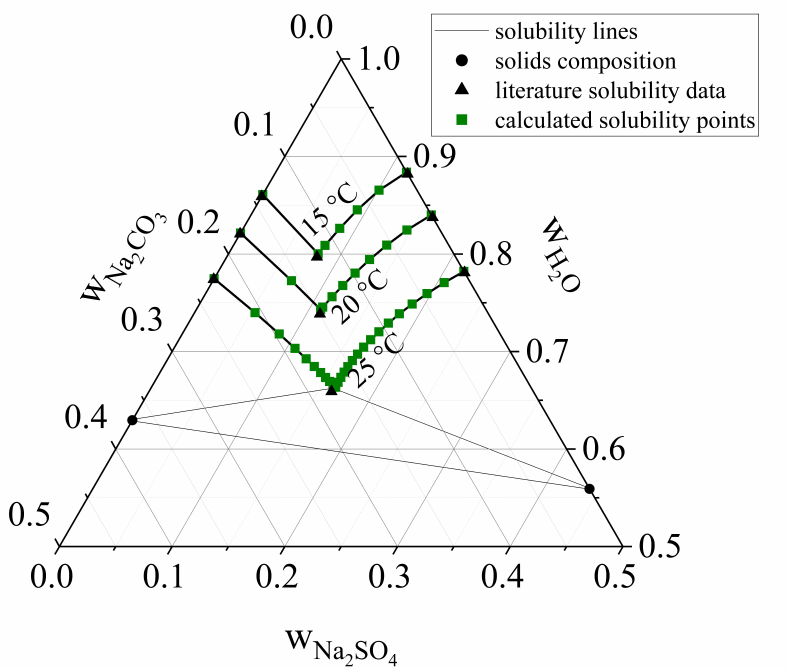
Figure 2. Ternary phase diagram of the Na 2 SO 4 -Na 2 CO 3 -H 2 O system with solubility lines at 15, 20, and 25 °C. All solubility points from the literature were taken from Caspari [41]. The green squares were calculated with the frezchem database using PhreeqC